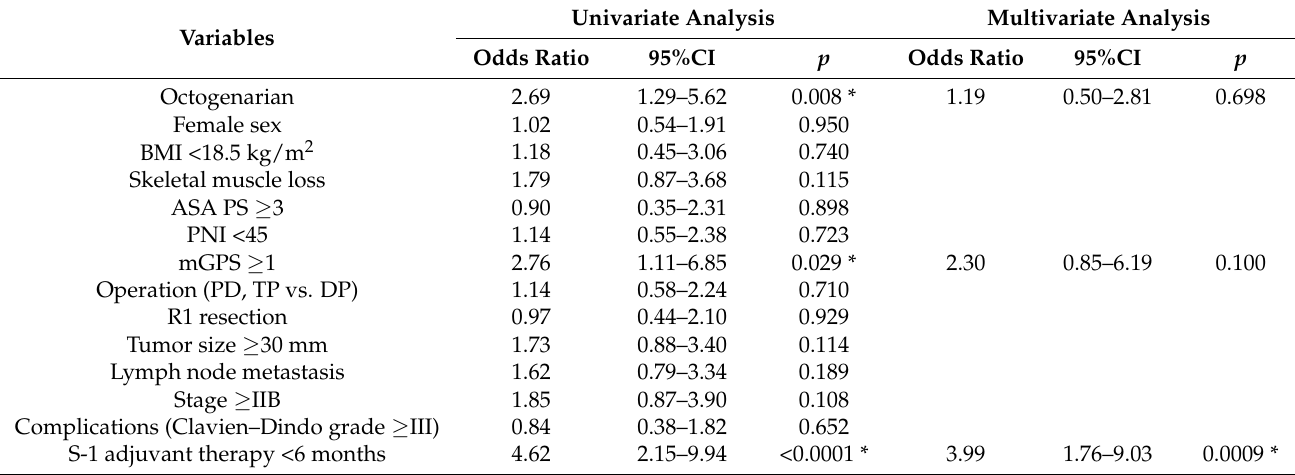
Table 2. Univariate and multivariate analyses of variables for OS in patients with pancreatic cancer.